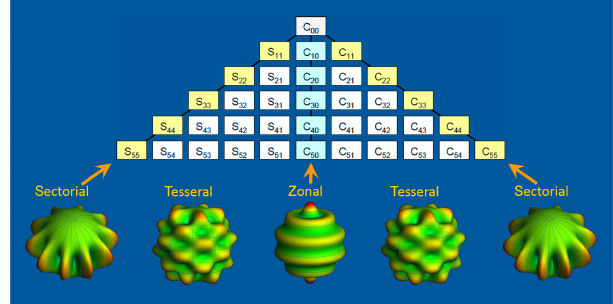
Figure 5. Mathematical representation of gravitational field po- tential using sectorial, tesseral, and zonal spherical harmonics. A spherical approximation of the gravitational field up to a maximum degree of l max consists of ( l max + 1) 2